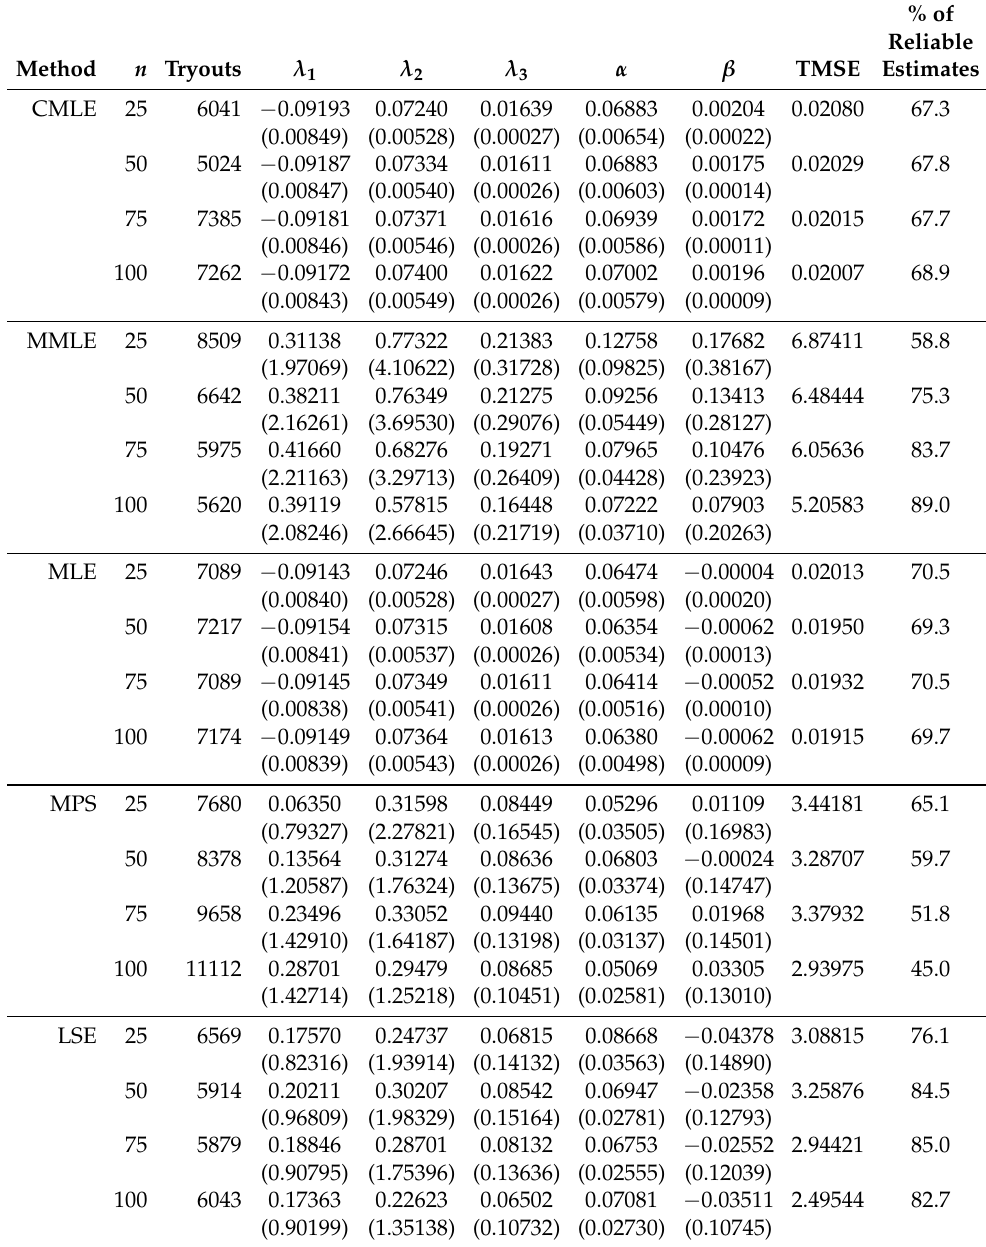
Table 5. Simulated biases and MSEs (in parentheses) of the parameter estimates obtained based